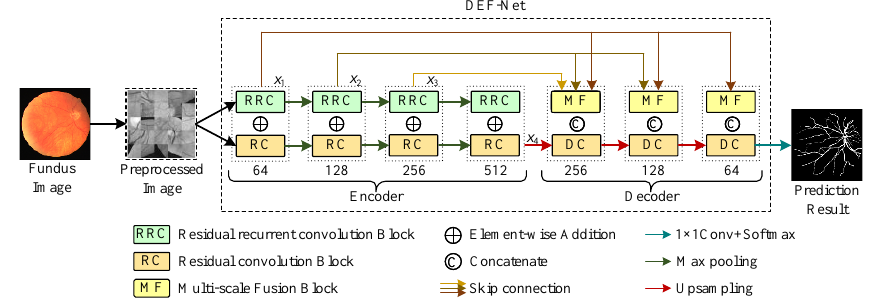
Figure 1. The framework of the proposed